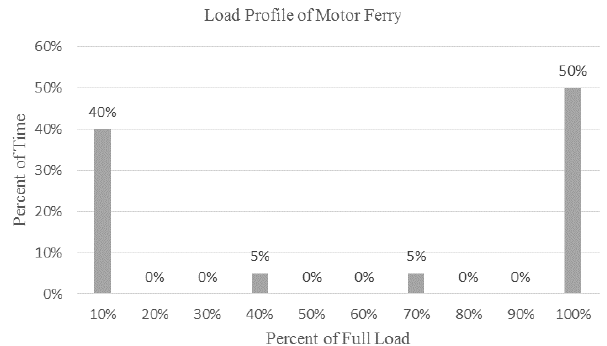
Figure 5. Load profile of a typical Motor Ferry.